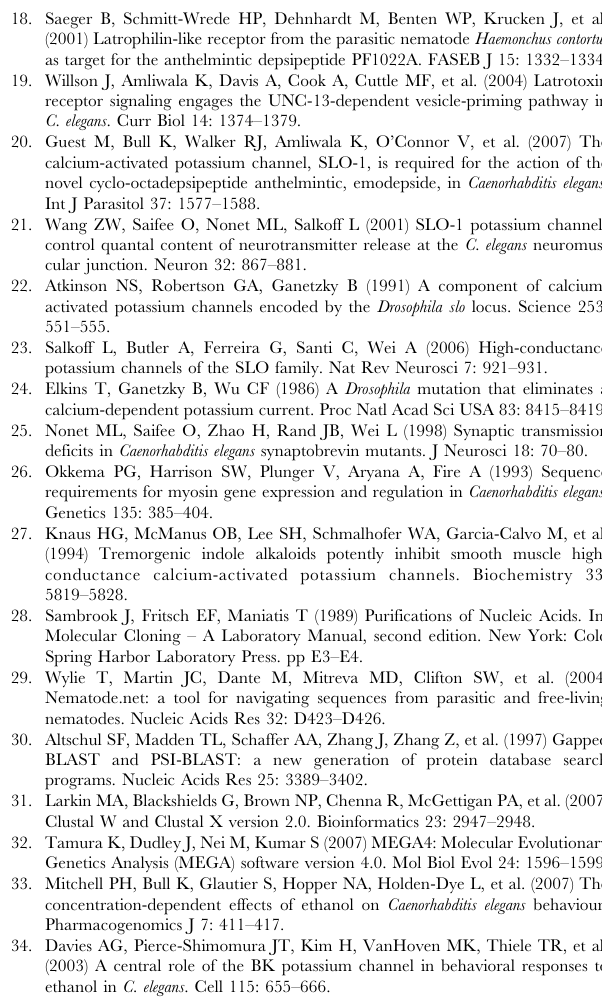
Table S1 Sequences of primers used for amplifying slo-1 coding sequences and putative promoter regions. The first primer pair for each target was used to amplify the fragment from cDNA, the second pair to introduce restriction sites for subcloning. Restriction sites are indicated by the name of the restriction enzyme in parentheses after the primer name and are underlined within the primer sequences.